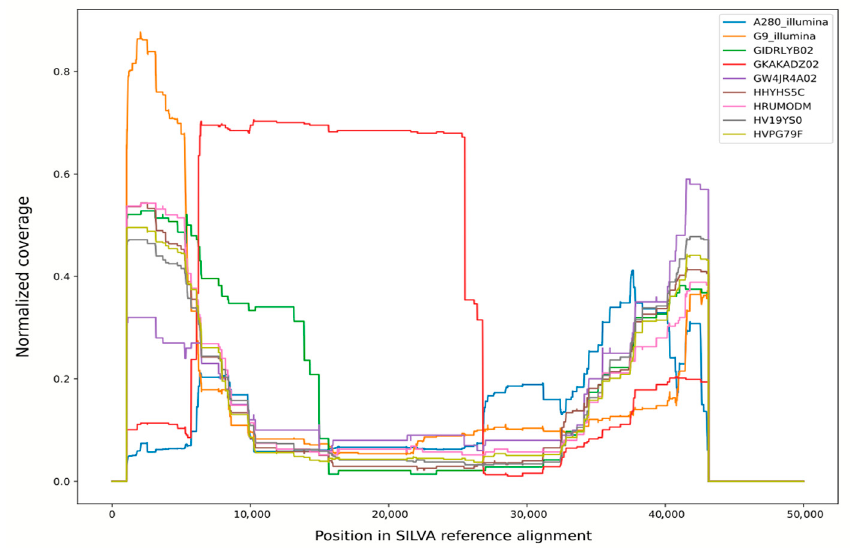
Figure 2. Normalized coverage of SILVA v138 reference alignment by bacterial and unclassified reads from various libraries. Libraries 27022013 and 14092013 were pooled for this analysis and shown as “G9-Illumina”. Table 1. Genomic libraries produced from Fragilaria radians strains G9 and Ax BK280. For PE Illumina libraries, the number of pairs is shown instead of the number of